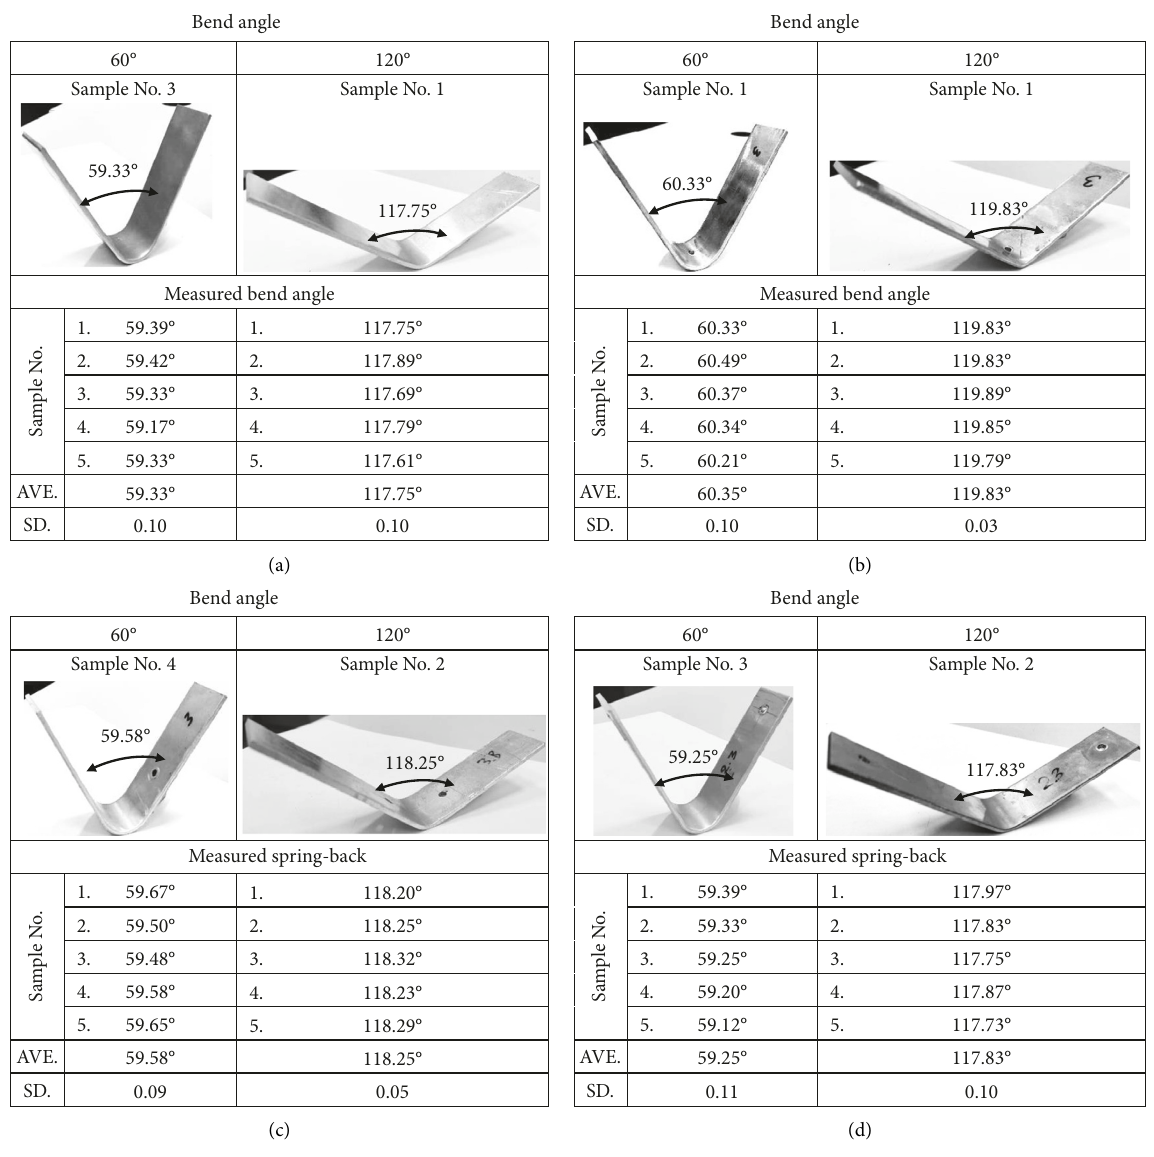
Figure 4: Comparison of bent parts and spring-back characteristic between bent parts with and without hole (hole diameter: 5mm). (a) Without hole. (b) Hole at bend radius zone. (c) Hole at next to bend radius zone. (d) Hole at leg